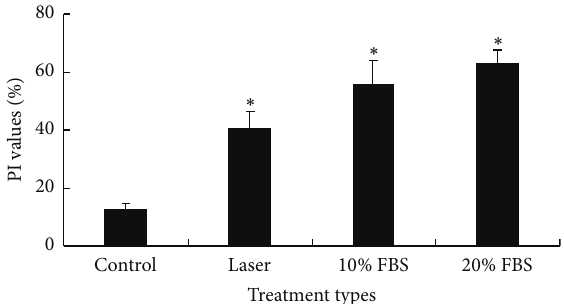
Figure 3: Cartogram of flow cytometric analysis about the proliferation index of myoblasts from each group as described above. Data are means ± SEM. ∗ 𝑃 < 0.05 , as compared with control.